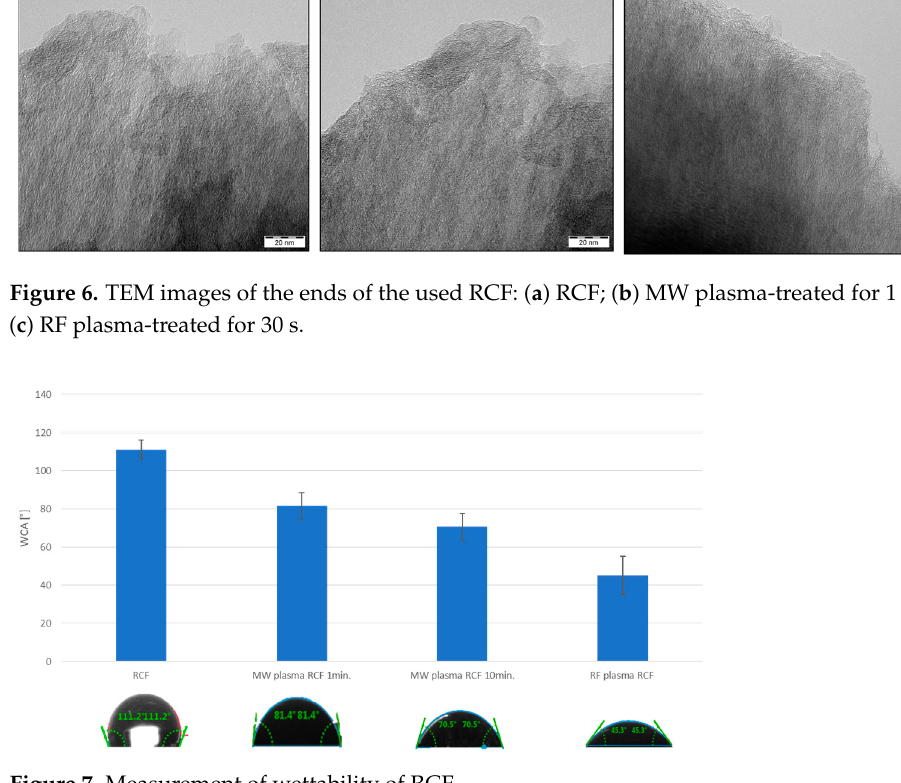
Figure 6. TEM images of the ends of the used RCF: ( a ) RCF; ( b ) MW plasma-treated for 1 min; and ( c ) RF plasma-treated for 30 s.